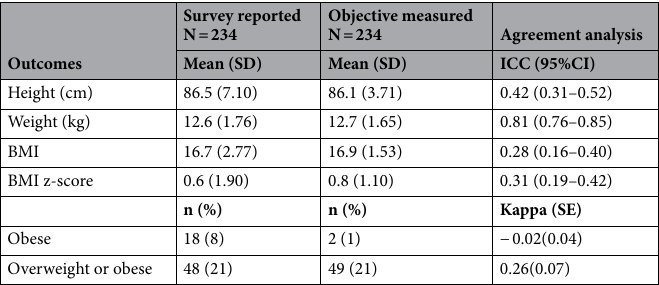
time gap increases (Supplement Table 2). The discrepancies in measured and reported data by participants’ char- acteristics were described in the supplement Tables 3 and 4. The proportion of those with obesity derived from self-report was 7% higher than that derived from the measured value, but the difference was not statistically significant ( P > 0.05). However, the proportion of those with combined overweight/obesity from the survey was the same as the measured value (Table 2). The agreement analysis showed a good agreement (ICC = 0.81) between the reported and measured weight, a moderate agreement between the reported and measured height (ICC = 0.42), but a poor agreement between reported and measured BMI (ICC = 0.28). The Kappa coefficient of 0.26 was also low in the classification of overweight or obesity status based on reported data. The scatter plots of measured height, weight and BMI values against reported values are provided in the Supplement Figs. 1–6. Quality of BMI correction models. The adjusted R 2 statistics were higher for models with weight as a depend- ent variable (66–74%) compared to models of height (27–28%), BMI z-score (16–19%) and BMI (11–17%). Not surprisingly, across all outcomes (height, weight, BMI z-score and BMI), the correction models derived from reported and measured anthropometrics within 7 days (Model 1) had a consistently highest adjusted R 2 compared to the models derived from data with a time gap within 30 days (Model 2) (Table 3). Considering the adjusted R 2 values were all below 75%, a random normal noise with mean 0 and standard deviation equals to the square root of the mean square error from the model was added to each prediction model to show the variability to the corrected value. The correction equations for height, weight, BMI and BMI z-score are listed below. Model 1 (time gap between the reported and measured within 7 days):